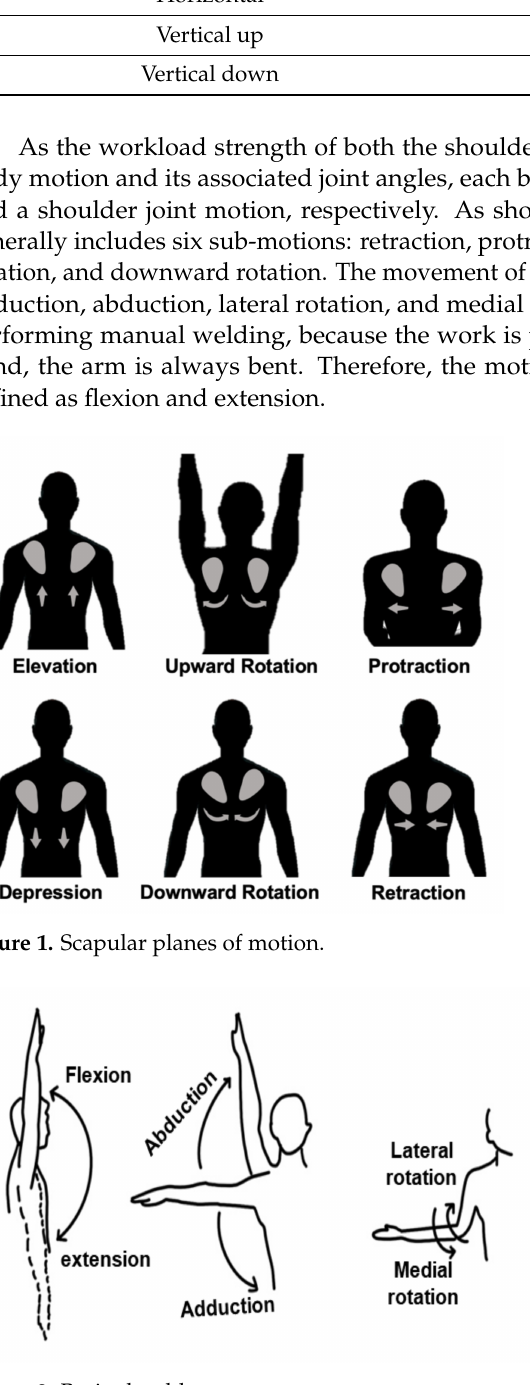
Figure 2. Basic shoulder